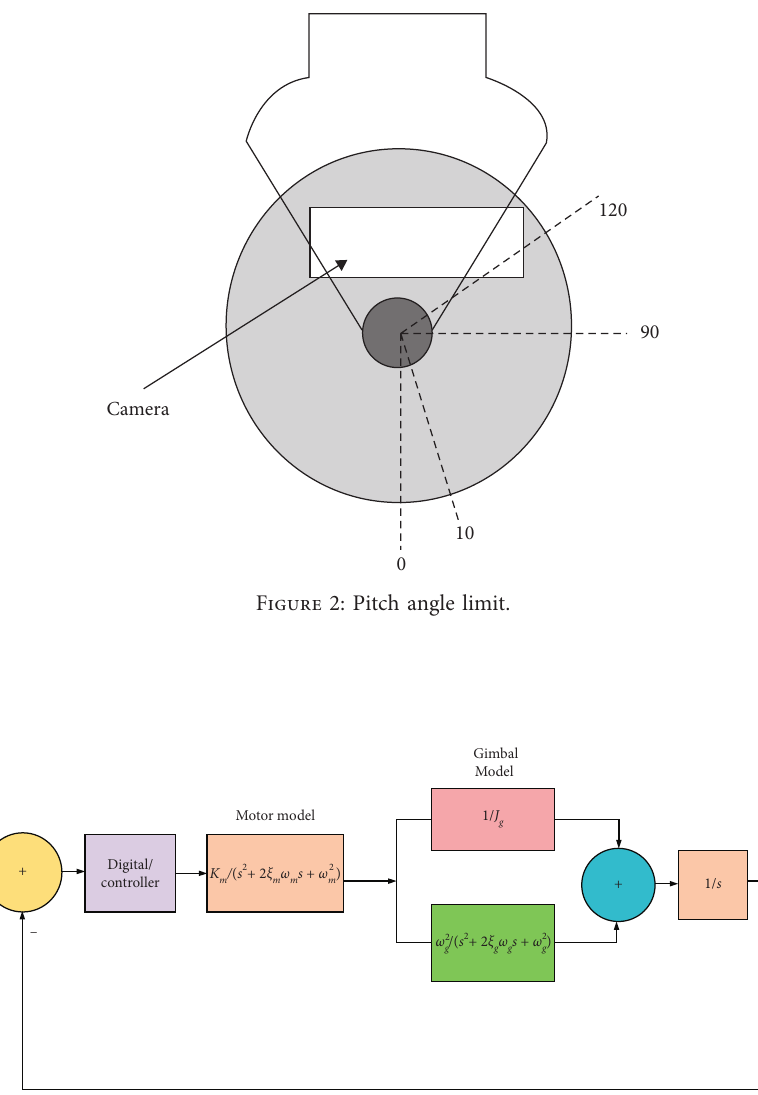
Figure 3: Block diagram of closed-loop identified linear